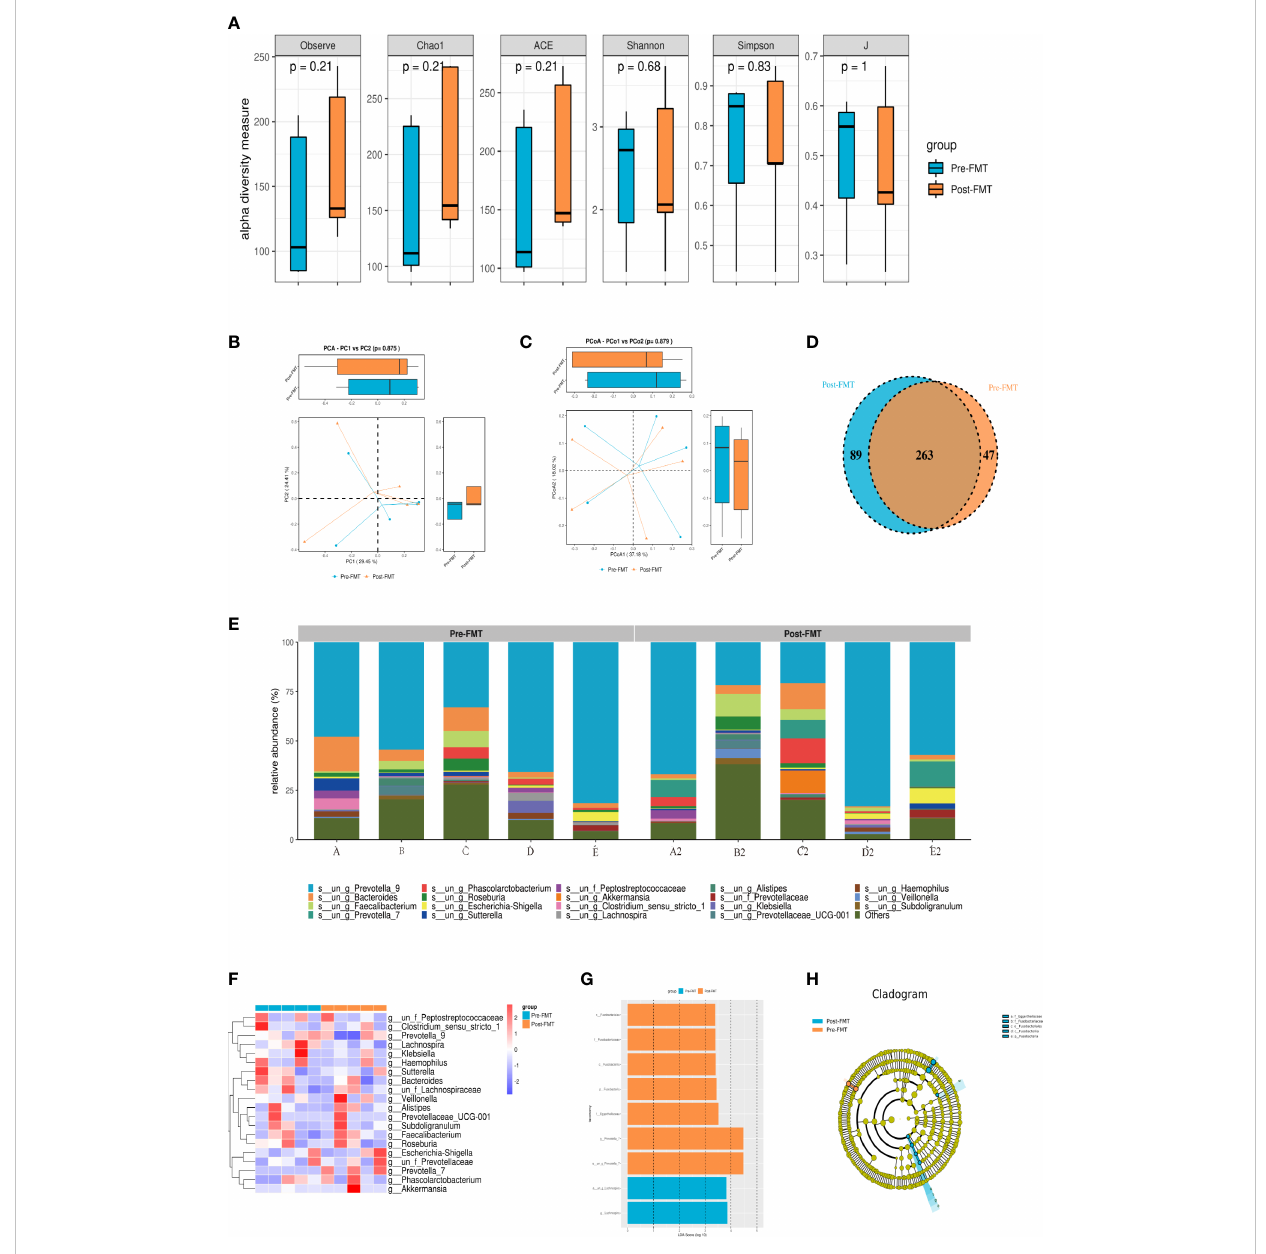
FIGURE 2 Results of 16S rRNA high-throughput sequencing analysis of gut microbiota before and after FMT. (A) Alpha diversity analysis of gut microbiota in patients before and after FMT. (B) PCA diversity analysis of gut microbiota in patients before and after FMT. (C) PCoA analysis of gut microbiota in patients before and after FMT. (D) OTU Venn diagram of gut microbiota in patients before and after FMT. (E) Community composition analysis of gut microbiota in patients before and after FMT. (F) Heatmap of gut microbiota in patients before and after FMT. (G, H) LEfSe analysis of gut microbiota in patients before and after